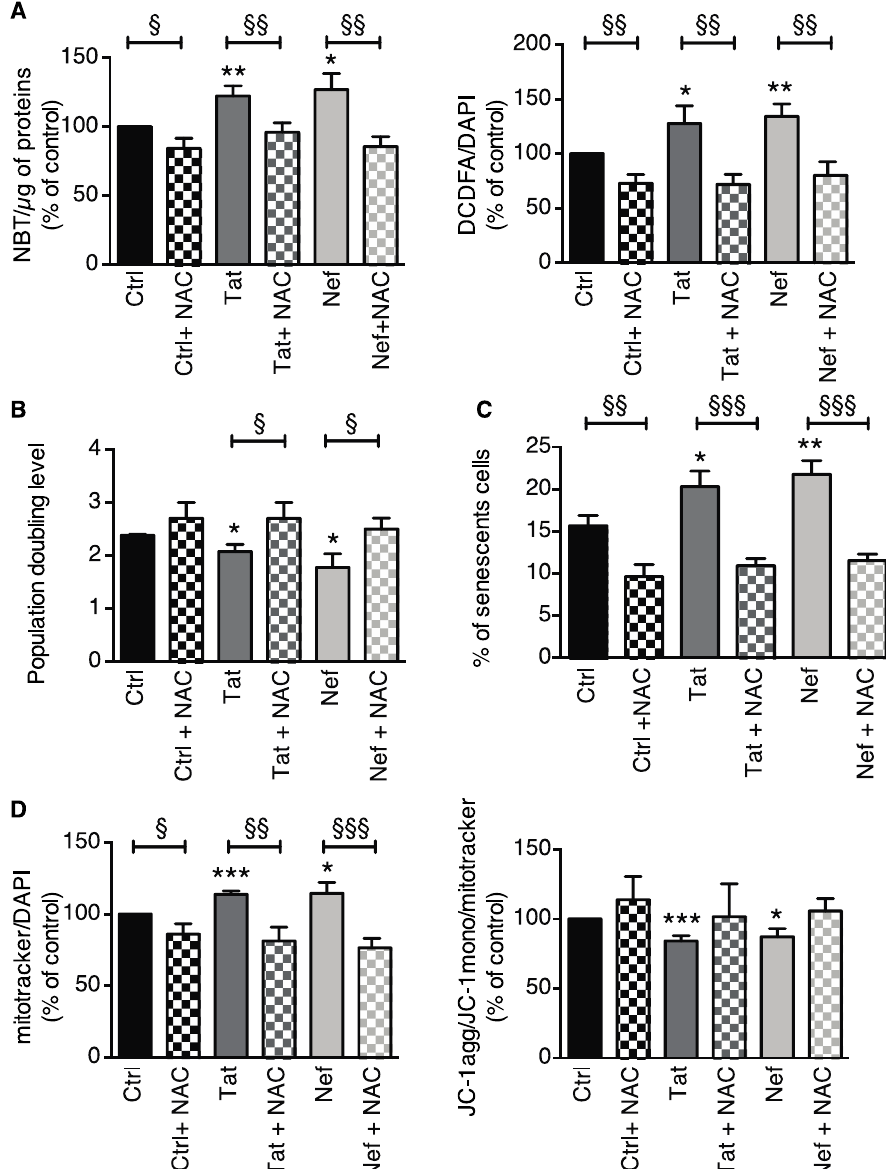
Figure 5. The suppression of oxidative stress using NAC prevented Tat- or Nef-induced senescence in ASCs. ASCs were treated with the HIV proteins Tat or Nef for 15 days. After these 15 days of treatment, we started a concomitant NAC treatment for 10 days. Experiments were performed on day 25 in ASCs, isolated from different abdominal SCAT healthy donors. ( A ) ROS production was assessed spectroscopically by measuring the NBT absorbance (normalized against protein content) and the CM-H 2 DCFDA fluorescence (normalized against DAPI) ( n = 5, in duplicate). ( B ) The population doubling level (PDL) was calculated as described previously ( n = 5, in duplicate). ( C ) Senescence was evaluated in terms of SA- β -galactosidase activity at pH 6 and expressed as the proportion (in %) of SA- β -galactosidase-positive cells ( n = 5, in duplicate). ( D ) Mitochondrial mass was evaluated using MitoTracker dye. The cationic dye JC-1 was used to evaluate the mitochondrial membrane potential. The fluorescence results are expressed as the mean ± SEM % JC-1 aggregate / monomer ratio. The results were normalized against DAPI fluorescence, and expressed as the mean ± SEM % of control cells ( n = 5, in duplicate). * P < 0.05, ** P < 0.01, and *** P < 0.001 vs. control cells. § P < 0.05, §§ P < 0.01, and §§§ P < 0.001 NAC-treated vs. nontreated